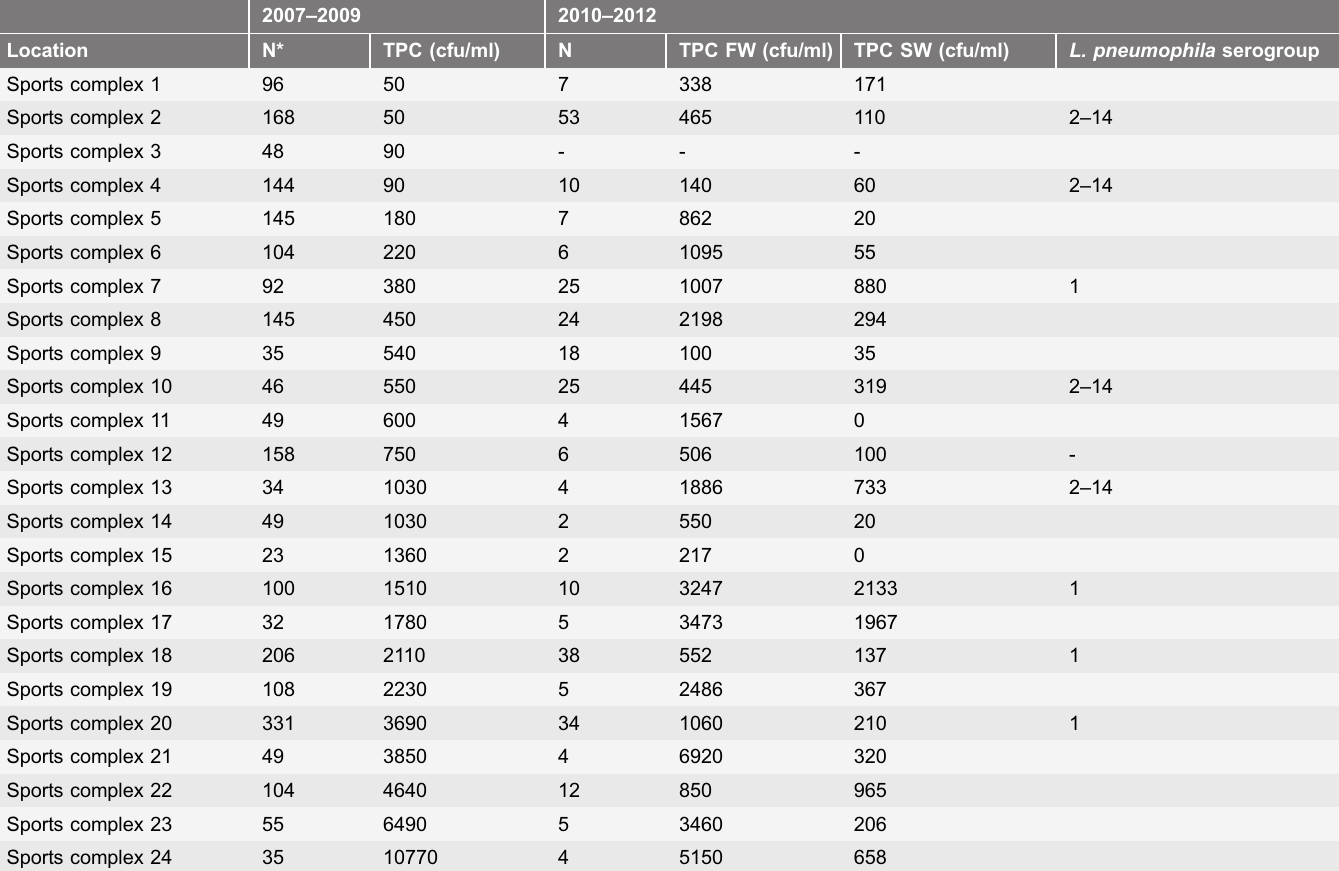
Table 2. Ranging of 24 sports complexes according to their mean Total Plate Count (TPC) from the period